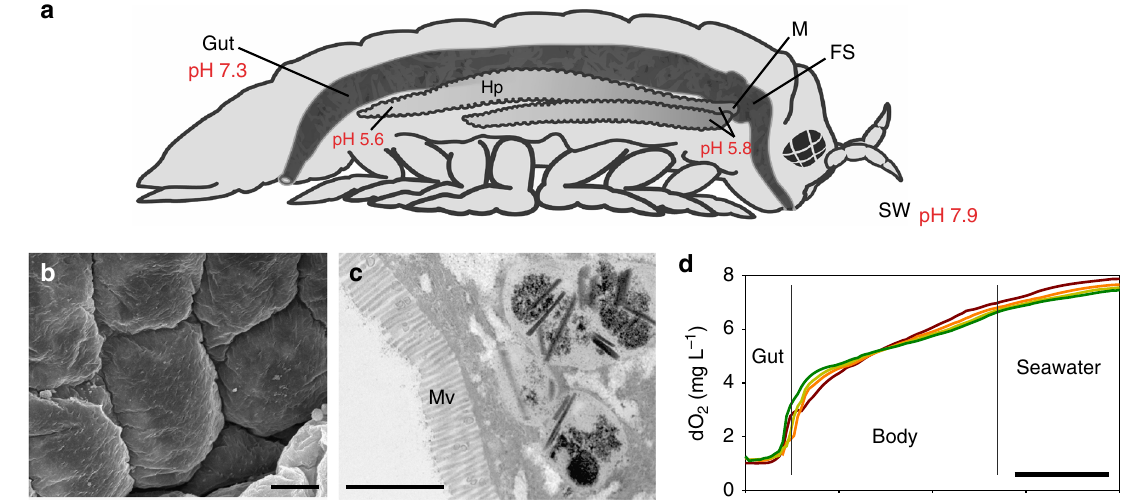
Fig. 2 Digestive system of Limnoria . a Schematic lateral view of the animal (typically 2 – 3 mm long) showing one of the two bi-lobed hepatopancreases (Hp) connected to the anterior of the tubular gut; position of manifold (M) and fi lter system (FS) as indicated, food mass in hindgut indicated by dark coloration; pH values indicated at points measured. b Scanning electron micrograph of chitinous cuticle lining of the hindgut (scale bar, 5 µ m). c Transmission electron micrograph of sectioned hepatopancreas cell with microvilli (Mv) facing the hepatopancreas lumen (scale bar, 2 µ m). d Oxygen concentration measured by a microprobe withdrawn from the hindgut (Gut) through the body of four individual animals into surrounding seawater (scale bar, 0.5